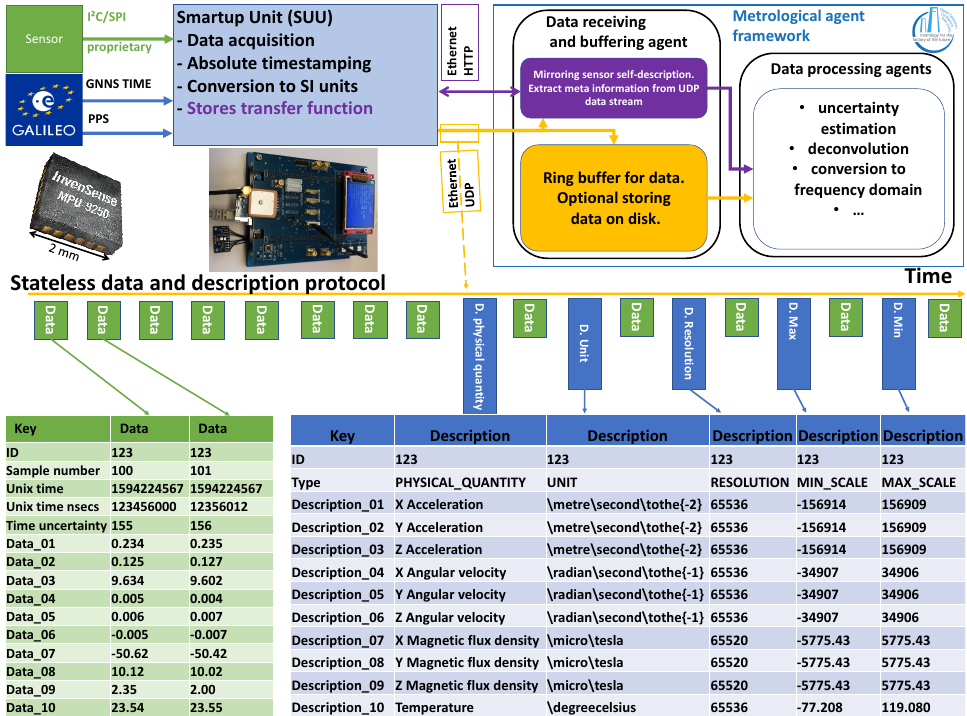
Figure 2. ( Top ) Dataflow from sensor via “Smartup Unit” to a receiving PC running an agent framework for data processing. ( Bottom ) Visualization of stateless data